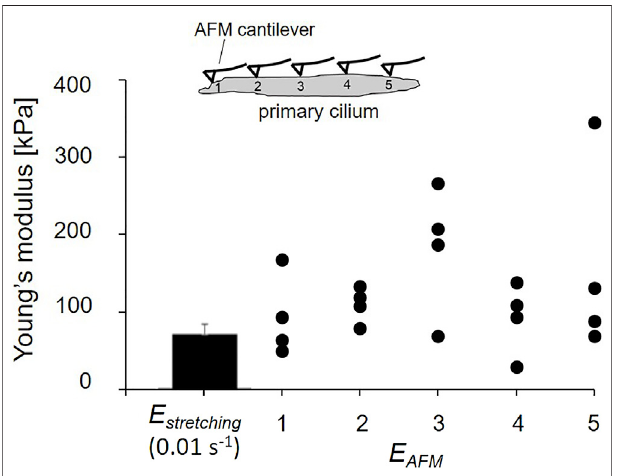
FIGURE 7 | Comparison of global E stretching and local E AFM .